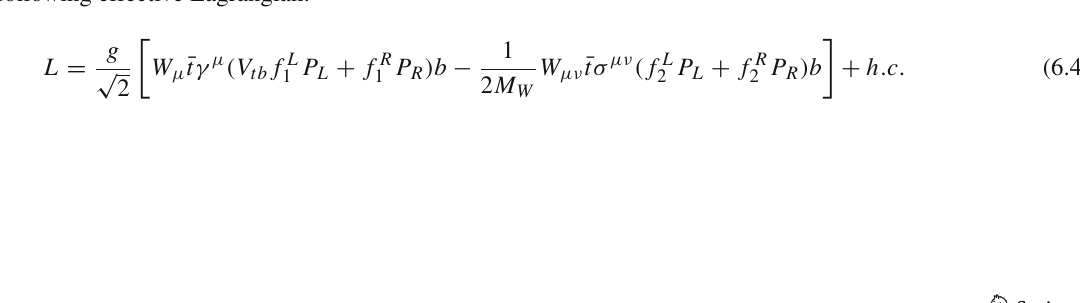
of 10, and much smaller contributions, of O (1%), from γγ jjW and γγ t ¯ t. For 10ab − 1 , 95% CL limits are set, combining both hadronic and semileptonic decays, with no (5%) systematics on background rates. For the tagged-charm analysis the limits are BR ( t → Hc ) < 4 . 9 × 10 − 6 ( 1 . 6 × 10 − 5 ) . Without charm tagging, these improve to BR ( t → Hq ) < 2 . 5 × 10 − 6 ( 2 . 8 × 10 − 5 )